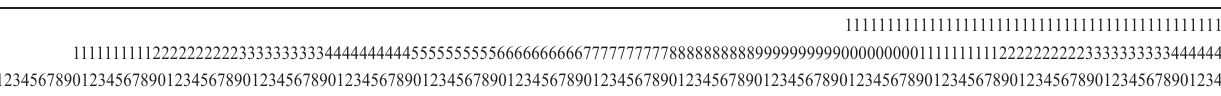
Table 2. States assignments of 144 characters for Phallotorynus pankalos modified the Lucinda & Reis (2005) phylogenetic